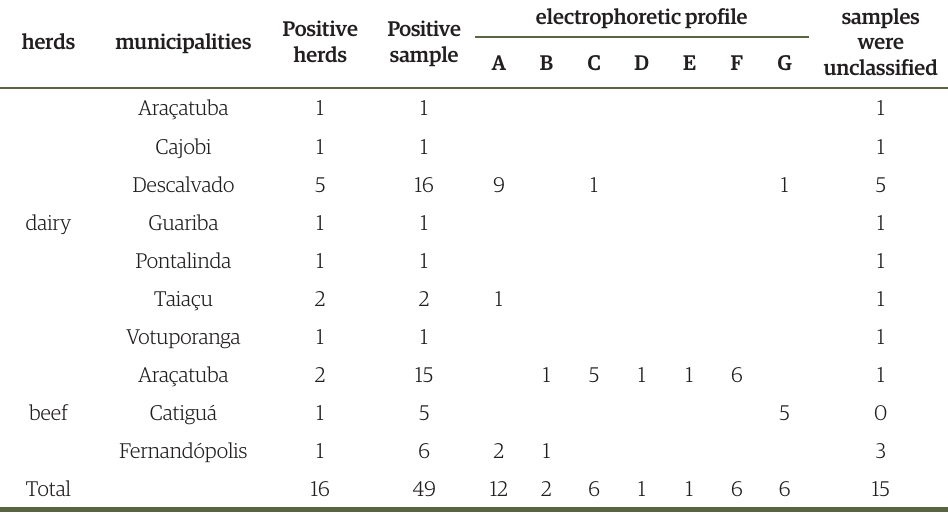
Table 5. Electrophoretic types of bovine rotavirus distributed according to the municipalities and the herds of origin, in calves of dairy herds and of cut of the north of the State of São Paulo, from 2006 to 2010.